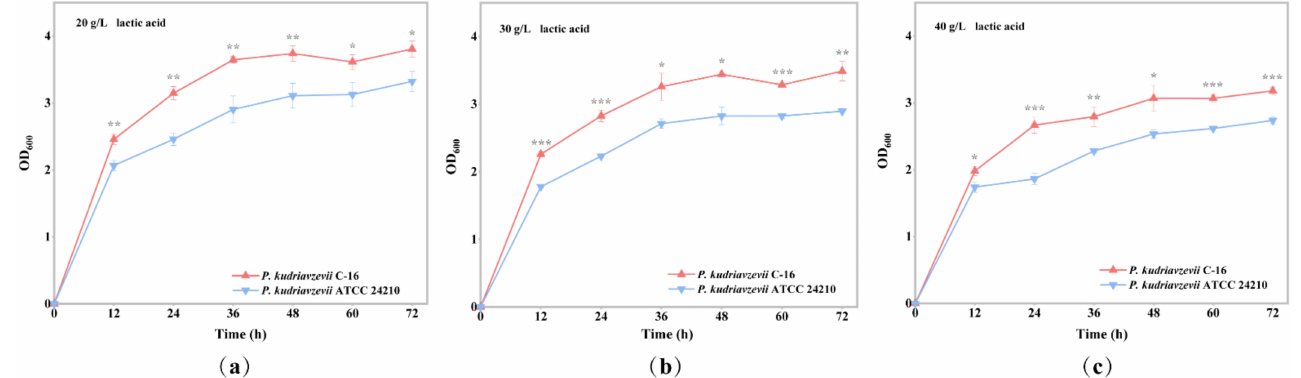
Figure 1. Biomass of P. kudriavzevii C-16 and the type strain ATCC 24210 under different concentra- tions of lactic acid. ( a ) Under 20 g/L lactic acid stress; ( b ) under 30 g/L lactic acid stress; ( c ) under 40 g/L lactic acid stress. The initial pH of the culture medium was adjusted to 3.5. * p < 0.05, ** p < 0.01, *** p <